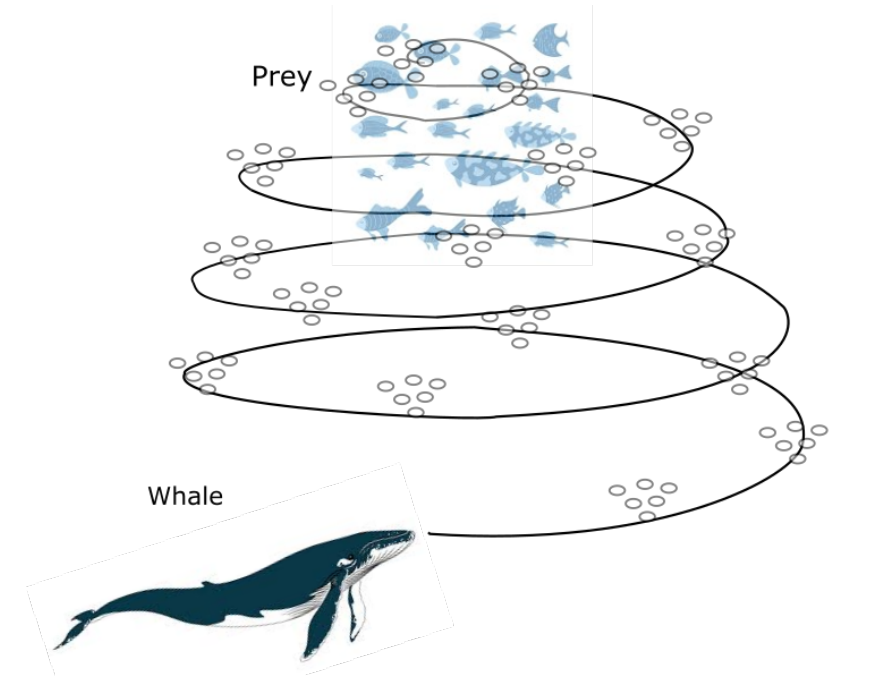
Figure 4. Whale hunting